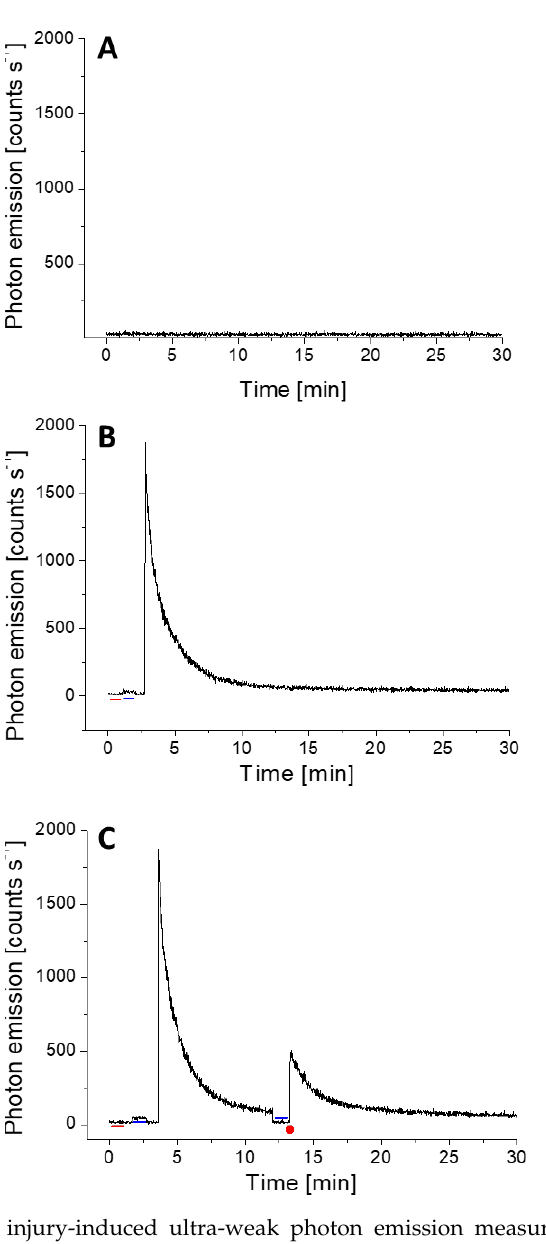
Figure 3. Mechanical injury-induced ultra-weak photon emission measured using PMT from Arabidopsis leaves. In ( A ), background level of photon emission was measured with an open shutter of the PMT. In ( B ), delayed luminescence from Arabidopsis leaf and its decay was monitored for 30 min. In ( C ), the delayed luminescence was measured for first 12 min followed by the kinetics of ultra-weak photon emission induced by mechanical injury (indicated by a red dot). In ( B , C ), the red and blue lines indicate the dark count and background noise, respectively. The decay curve in total was measured for 30 min.